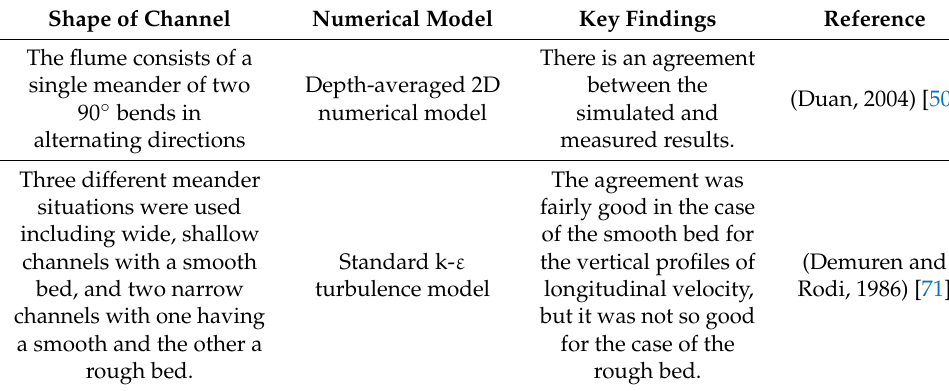
Table 2. Summary of studies about pollutant dispersion in curved channels used in Section